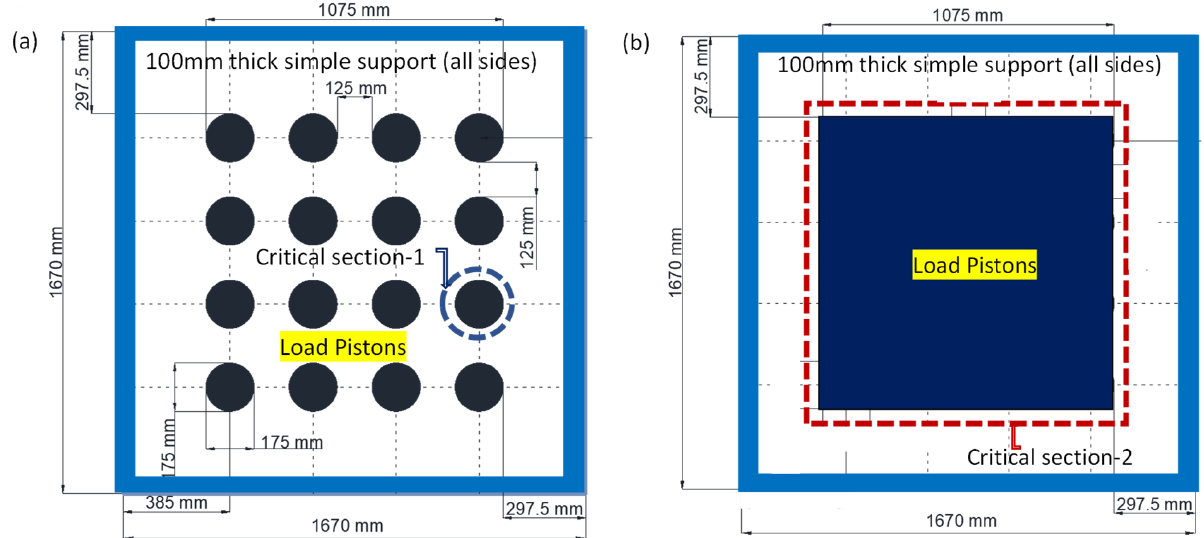
Figure 11. Critical sections to calculate the punching shear force capacity of the slabs. ( a ) Critical Section 1 around individual loading piston; ( b ) Critical Section 2 around total loading piston. Table 9. Experimental and theoretical punching shear capacity of the CFRP- and BFRP-RC slabs based on different analytical models.